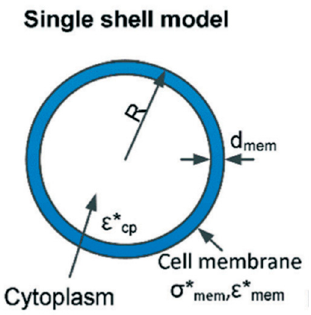
Figure 1. Single shell model of a cell where ε and σ denote permittivity and conductivity, respectively. Subscripts mem and cp refer to the properties of the cell membrane and cytoplasm, respectively [44].